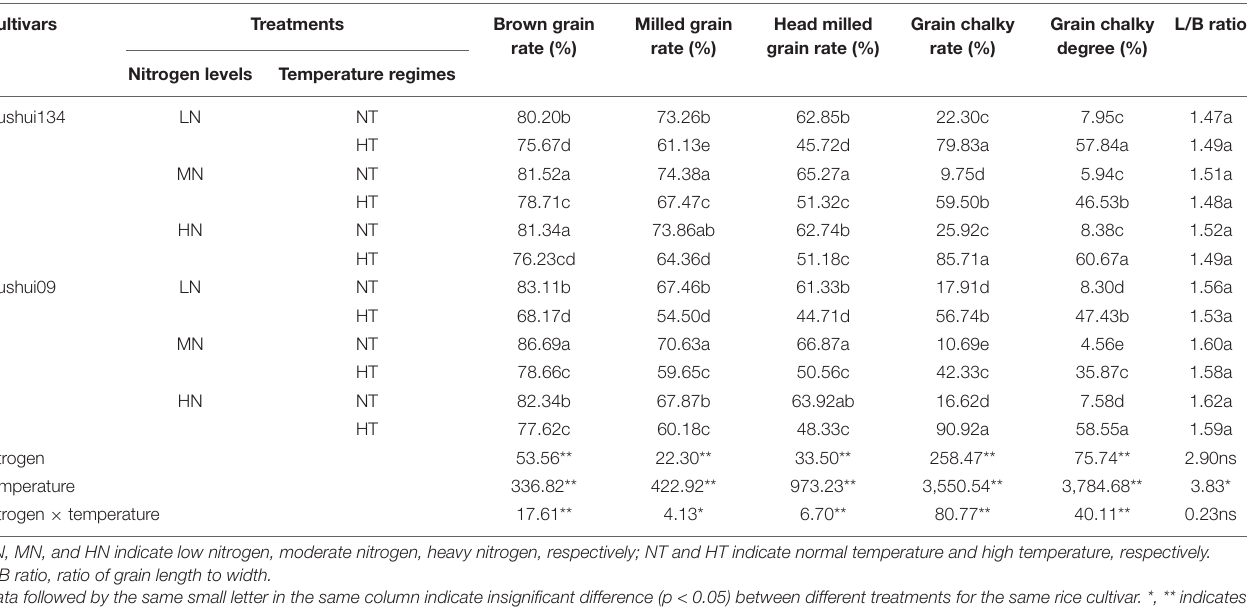
TABLE 1 | Difference in milling property and appearance quality among different treatments.